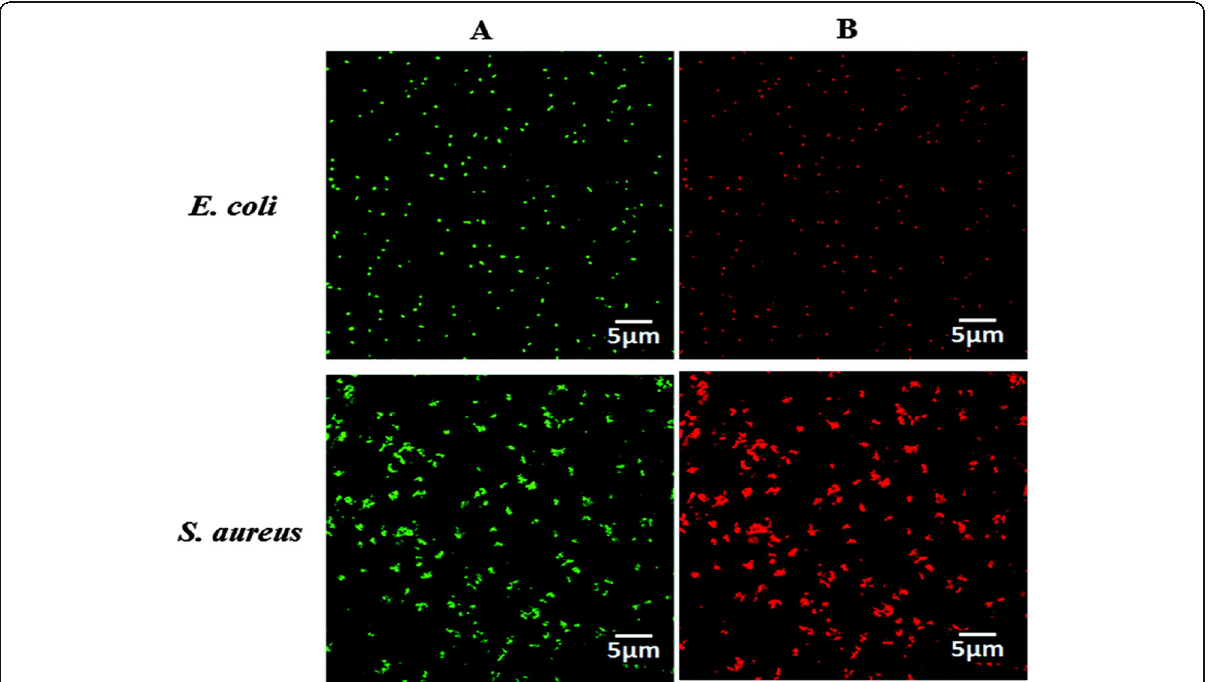
Fig. 6 Fluorescence microscopy images of E. coli and S. aureus treated ( a ) without and ( b ) with ZnO – PVA NPs. Green fluorescence is characteristic of live cells, whereas red fluorescence is due to dead cells. Reproduced from ref. [14] with permission from The Royal Society of Chemistry